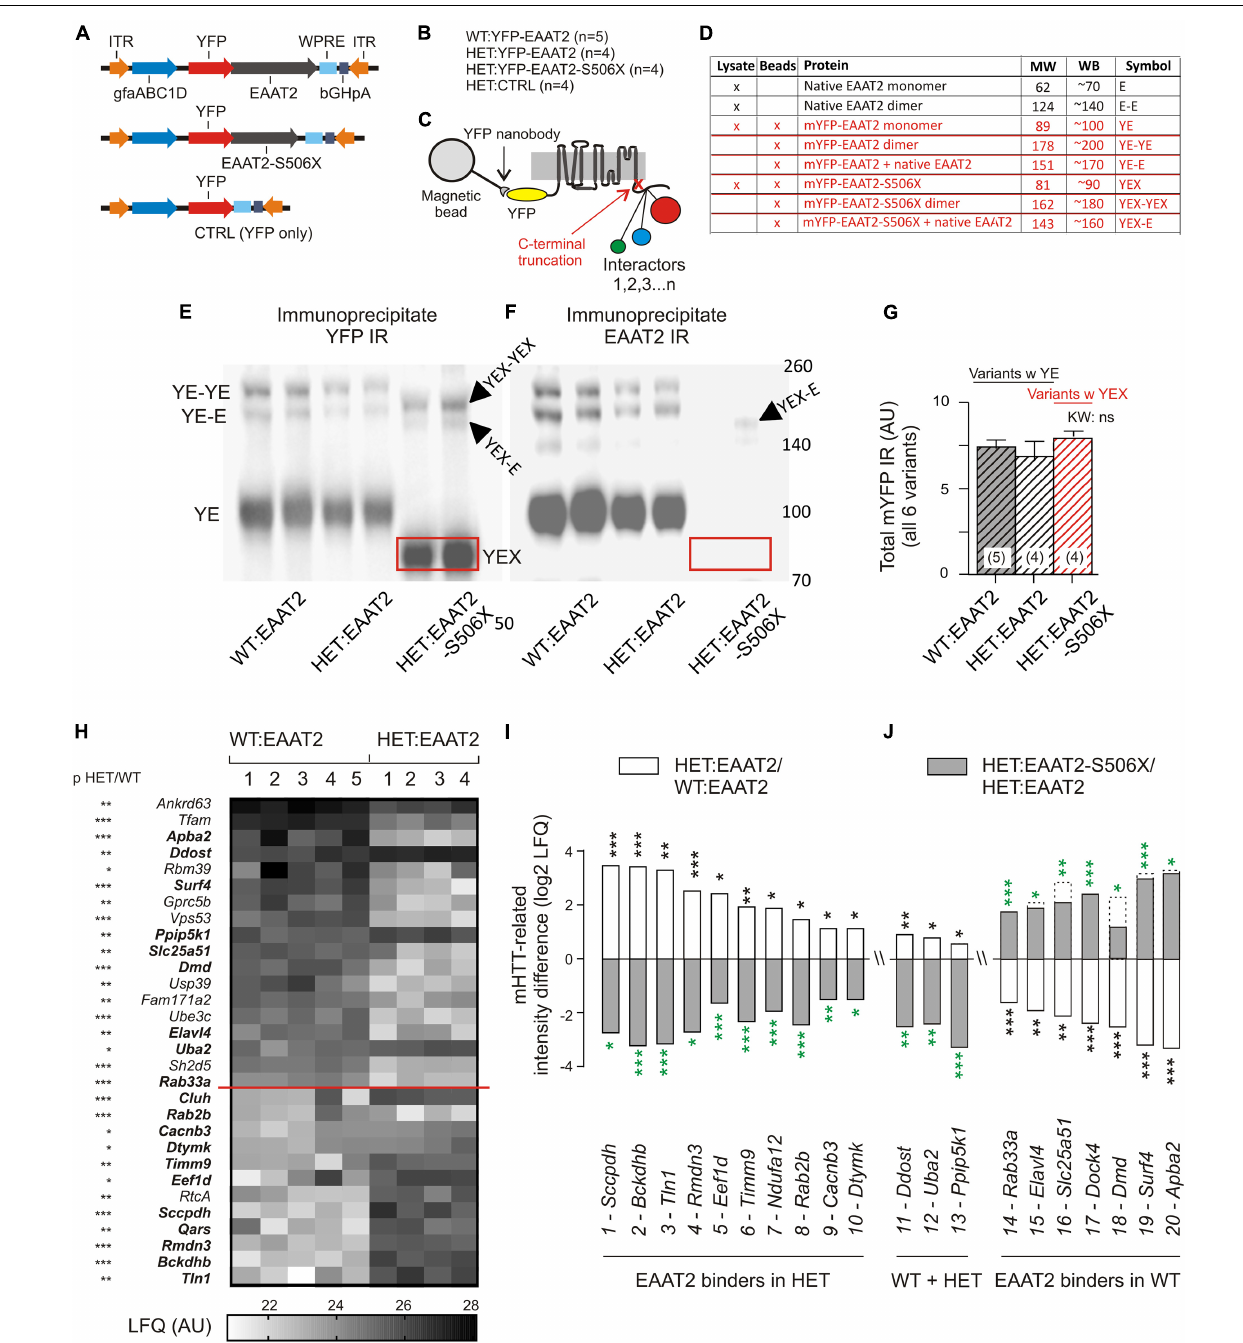
FIGURE 2 | mHTT- and S506X-related changes in the abundance of YFP-EAAT2 binders. (A) Injected vectors. (B) Animal groups. (C) Scheme of immunoprecipitation experiment. (D) List of EAAT2 bands to be detected in the Western blots (WB) from the beads preparation (this figure) or lysates ( Figure 3 ). (E,F) Western blot samples prepared from the beads YFP-immunoprecipitate. Note dimer bands and shift of the EAAT2-S506X band (YEX, boxed). (G) Similar amounts of mYFP immunoreactivity (YE or YEX bands) pulled down in the three animal test groups. (H) Heat-map plot illustrating the mHTT-related differences between WT:EAAT2 and HET:EAAT2. The signal from each animal was normalized to the mYFP median intensity value in a histogram constructed from all samples. The inter-group intensities were compared by a two-tailed t -test. The asterisks next to the listed genes denote the significance level of the difference. The proteins are listed with their gene names and sorted according to their abundance in WT:EAAT2. (I,J) Plot illustrating the recovery potential of significant EAAT2 binders. The LFQ intensity difference denotes the log2 difference between the compared groups. Compared were WT:EAAT2 vs. HET:EAAT2 (empty bars with black asterisks) and HET:EAAT2-S506X vs. HET:EAAT2 (filled bars with green asterisks). The dashed bars indicate the corresponding WT levels. An up-regulation is shown as upward bar, a down-regulation as downward bar. * p < 0.05, ** p < 0.01, *** p < 0.001.